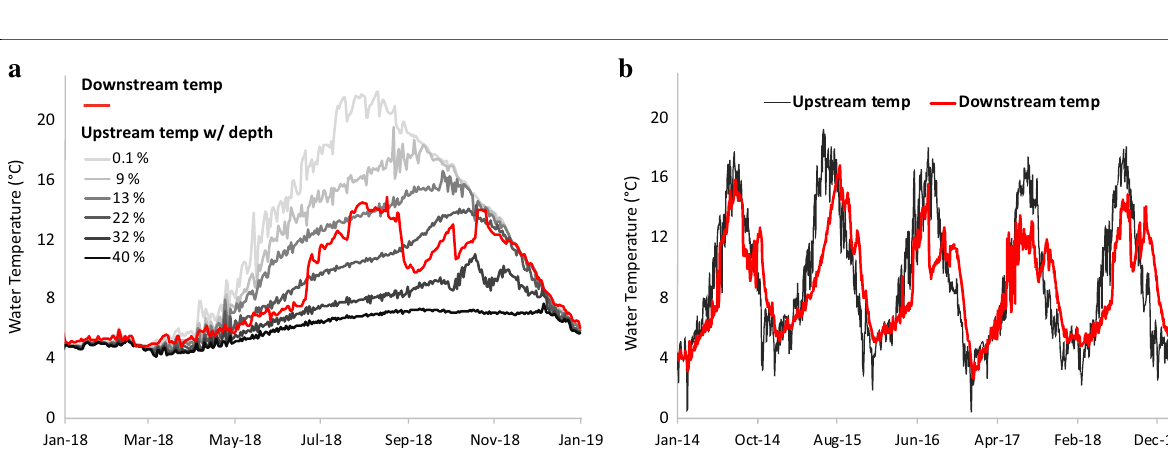
Fig. 3 a Variation of upstream reservoir temperature with depth from spillway crest plotted as a percentage of maximum reservoir depth (440 ft) for Detroit dam (OR) in 2018. Downstream temperature is also plotted alongside; b time-series of stream temperatures upstream and downstream of dam showing alteration in downstream thermal regime, where flow-averaged temperature of upstream tributaries from USGS gages are used for upstream temperature [Source: USGS; USACE